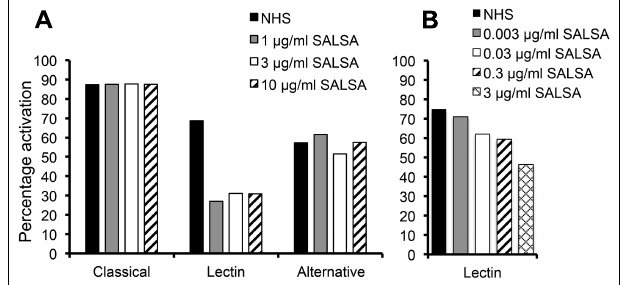
FIGURE 1 | Inhibition of complement activation by fluid-phase SALSA. In an ELISA assay (Wieslab ® ) SALSA (0–10 μ g/ml) was diluted in NHS and the activation of the classical, the lectin, and the alternative pathway of complement was measured. Inhibition of the lectin pathway but not the classical or the alternative pathways was observed when SALSA was added (A) .The effect on the lectin pathway was investigated with further dilutions of SALSA.This revealed a clear dose-dependency (B) . Data from single experiments performed in duplicate are shown.The results are expressed as percentage of activation in a standardized control serum pool supplied by the